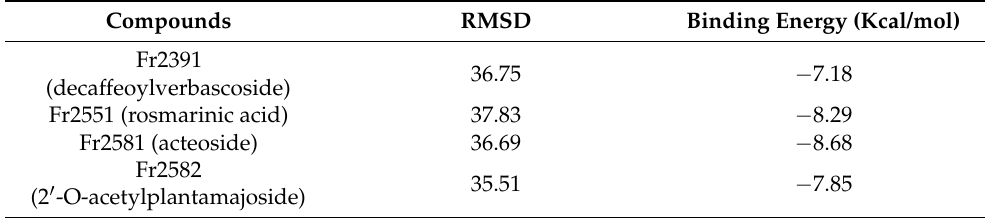
Table 1. Binding energy of Fr2391, Fr2551, Fr2581, and Fr2582 in Nrf2 (PDB ID: 4IQK).